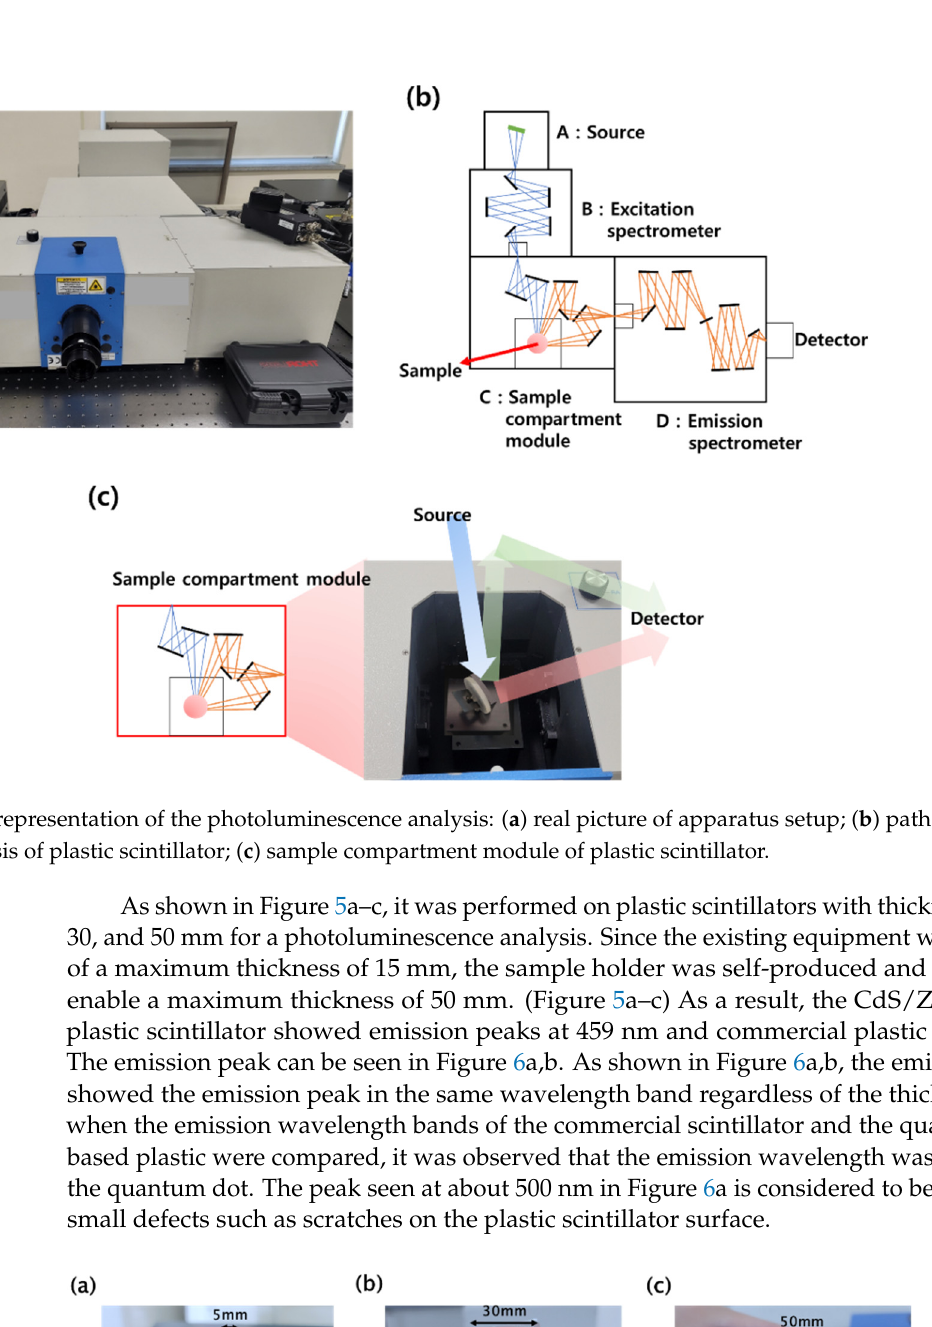
Figure 6. Photoluminescence analysis of ( a ) commercial plastic scintillator and ( b ) CdS/ZnS-based plastic scintillator. 3.2. Simulations for Optimum Thickness of Plastic Scintillator A diameter of 50 mm and a thickness of 10 to 100 mm were simulated, and optical photons were set to be generated according to the Poisson distribution. The measurement results were compared with the results of two computer codes, and the characteristics of the computer codes used in this study are shown in Table 2. Table 2. Comparison of characteristics of MCNP and GEANT4. Simulation Codes